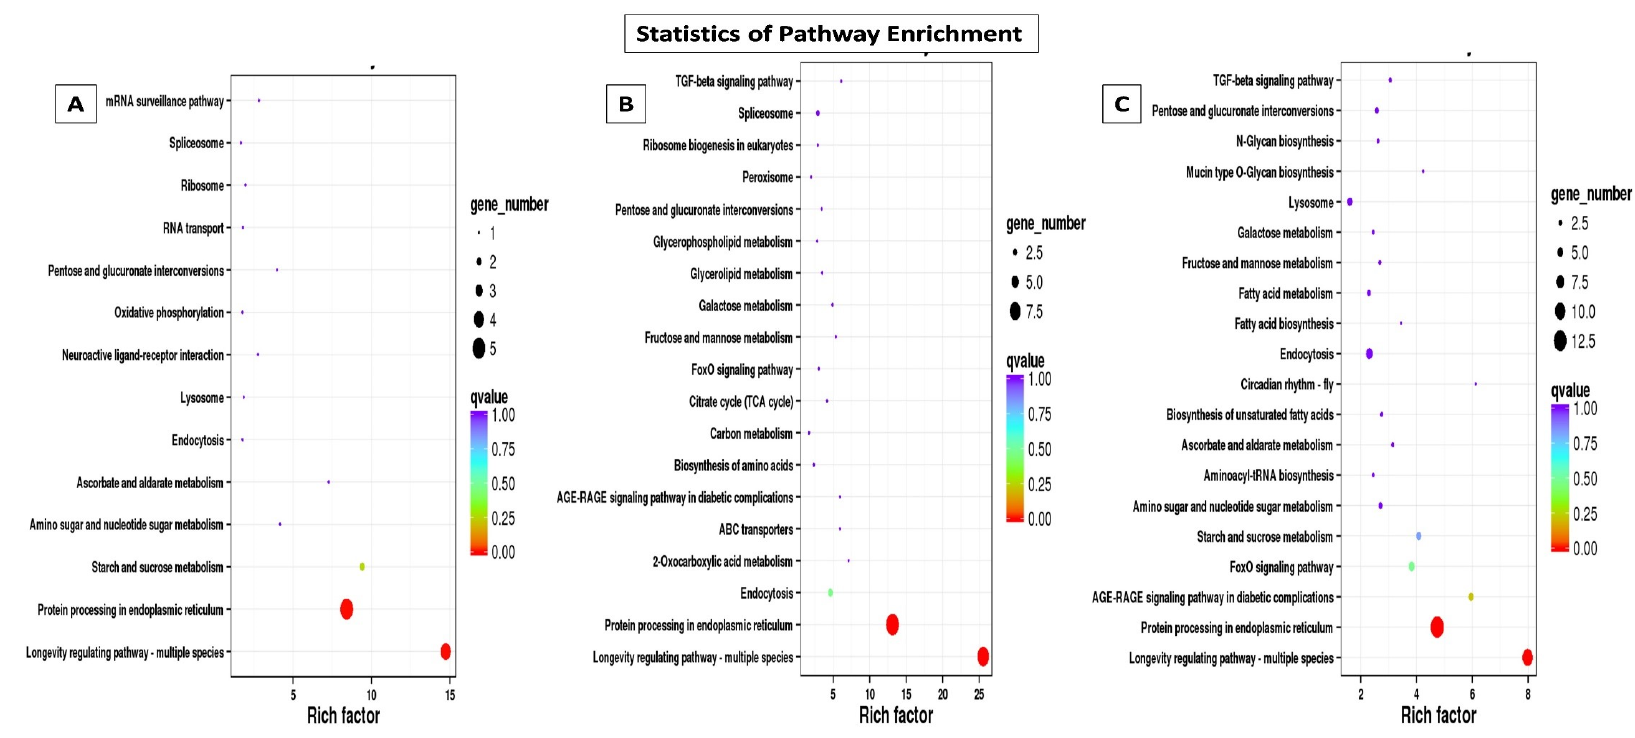
Figure 10. Kyoto Encyclopedia of Genes and Genomes (KEGG) pathway enrichment scatter plot. The vertical axis represents the path name, and the horizontal axis represents the path factor corresponding to the Rich factor. The size of the q-value is represented by the color of the point. The smaller the q-value, the closer the color is to the red color. The number of differential genes included in each pathway are expressed by the size of the point. Control vs B. bassiana ( Control vs. BB) ( A ); Control vs B. bassiana + T. asperellum (Control vs. BB+TH) ( B ) and Control vs T. asperellum (Control vs. TH) ( C ).